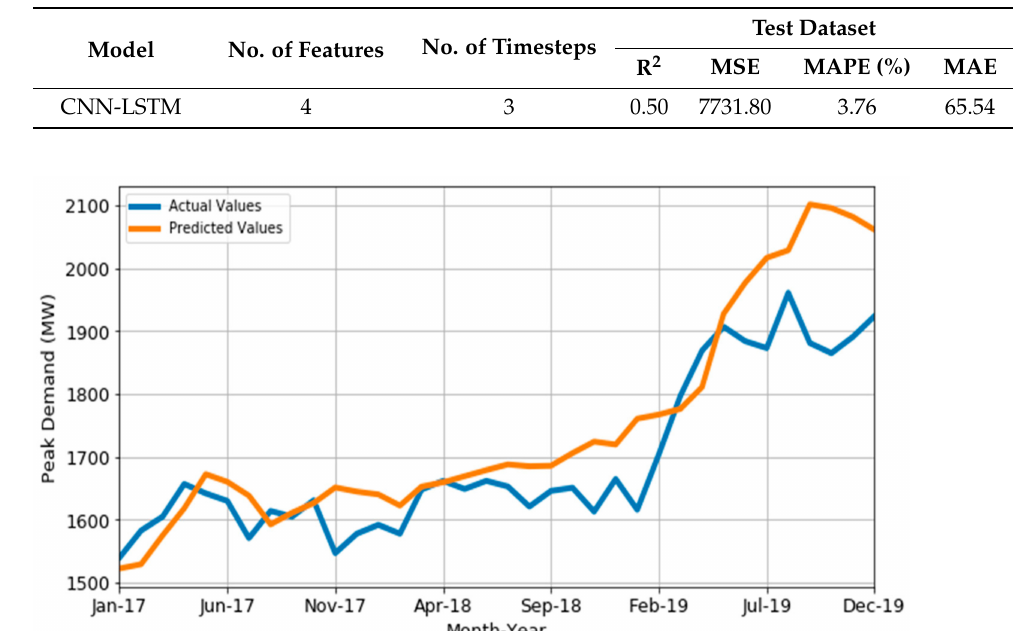
Table 9. Results of the multivariate CNN-LSTM model on the test set.